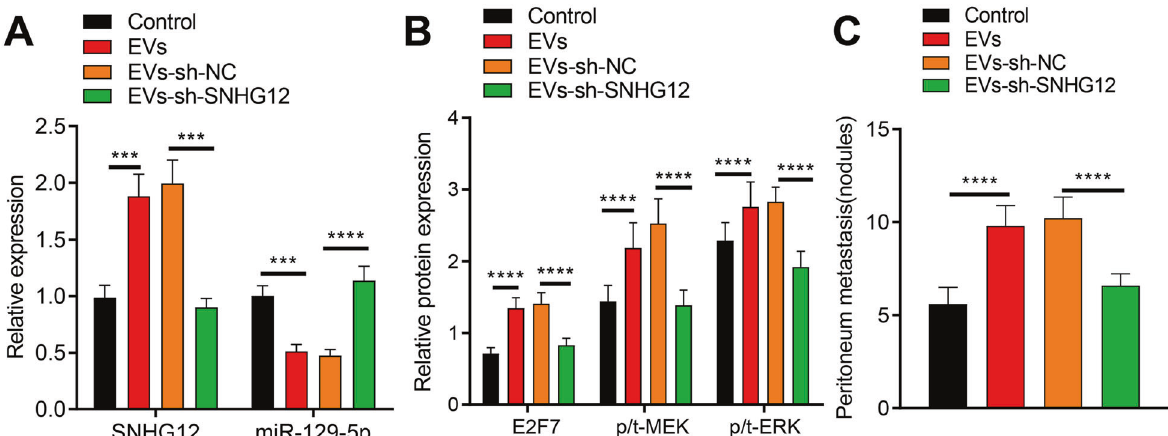
Fig. 6 GC cells derived EVs-SNHG12 affects peritoneal metastasis of GC cells. Note: NCI-N87 cells were injected alone or co-injected with EVs. A The expression patterns of SNHG12 and miR-129-5p in peritoneal tissues of nude mice evaluated using RT-qPCR. B The expression patterns of E2F7, p/t-MEK, and p/t-ERK in peritoneal tissues of nude mice evaluated using western blot analysis. C The number of peritoneal nodules in nude mice detected by HE staining. n = 15. p < 0.05, p < 0.01, *** p < 0.001, **** p < 0.0001. The experiment was conducted three times